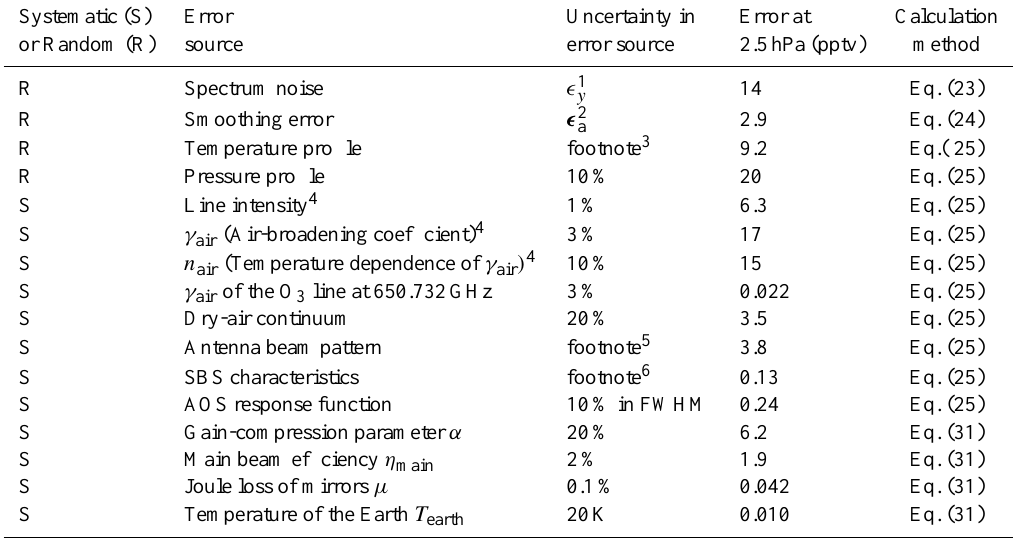
Table 2. Summary of the error sources for a single-scan observation. Systematic (S) Error Uncertainty in Error at Calculation or Random (R) source error source 2.5hPa (pptv) R Spectrum noise R Smoothing error Temperature